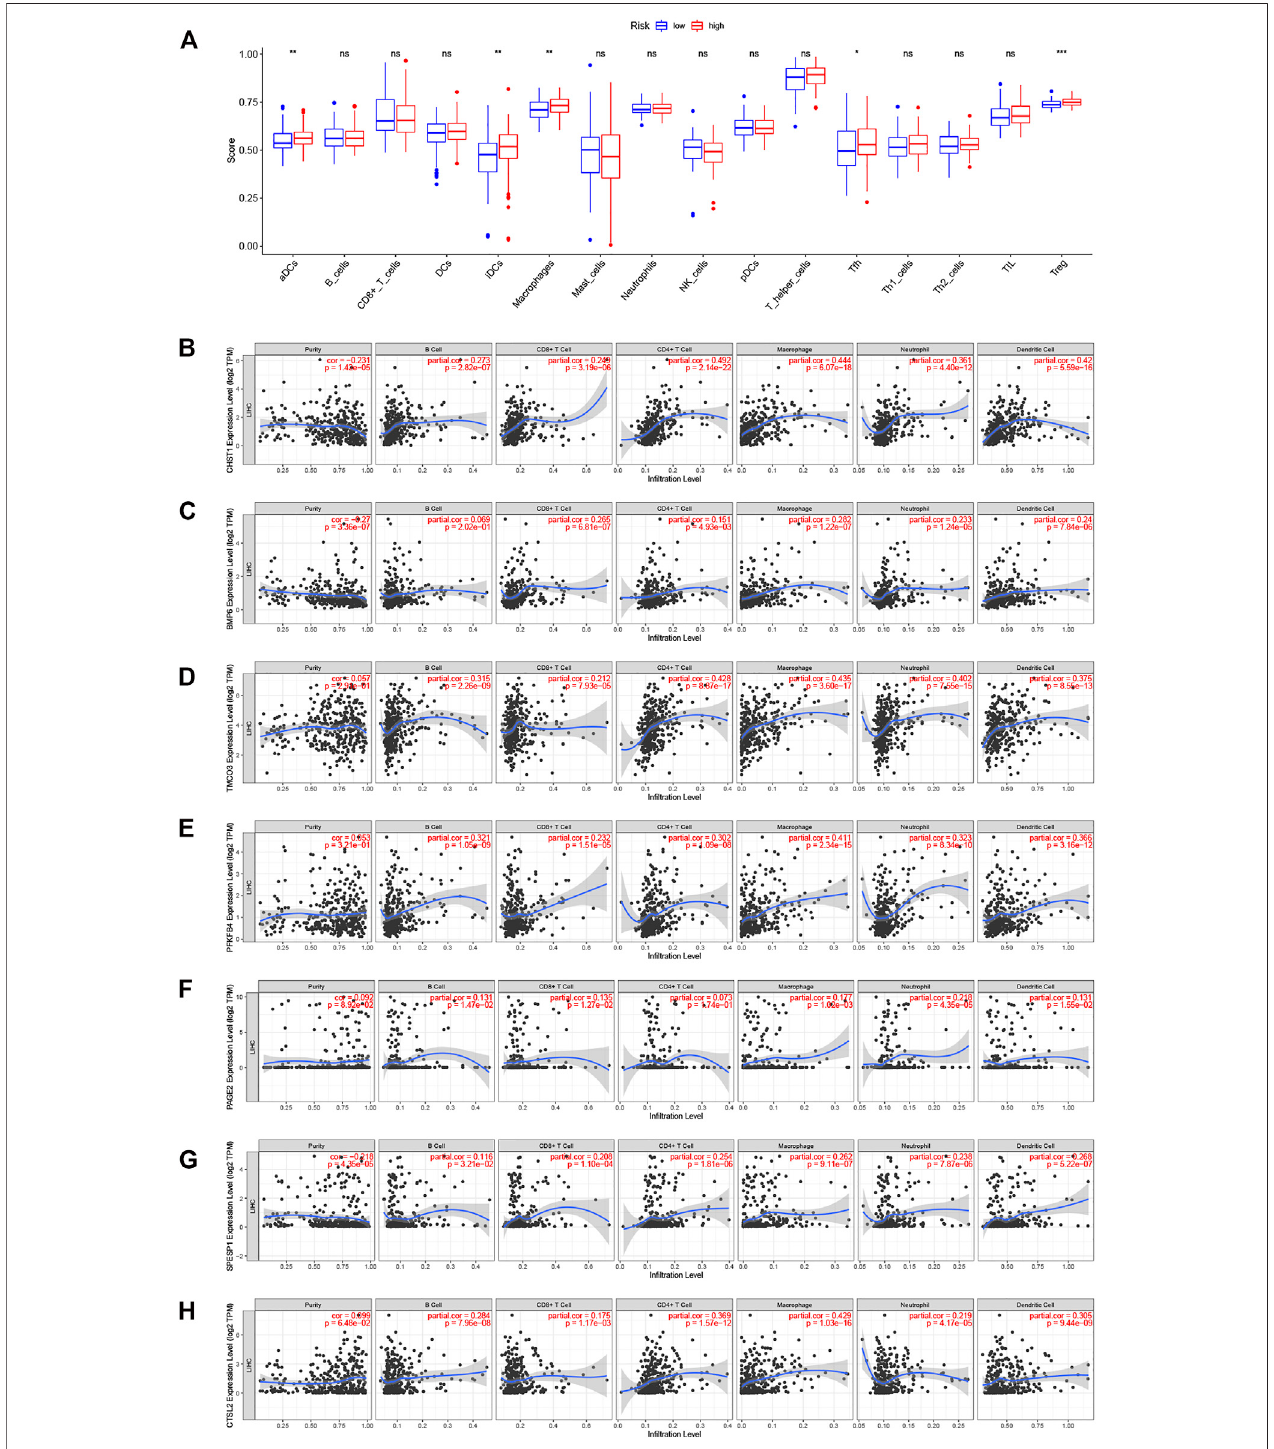
FIGURE 8 | Relationships between seven DERNGs and immune in fi ltration. (A) Boxplot comparison of immune cell in fi ltration in the two groups. (B – H) Partial correlationanalysisofDENRGsexpressionlevels,tumorpurity,andin fi ltrationdegreebyTIMERdatabase. (B) CHST1 (C) BMP6 (D) TMCO3 (E) PFKFB4 (F) PAGE2 (G) SPESP1 (H) CTSV(CTSL2). * p < 0.05, ** p < 0.01, and *** p < 0.001.